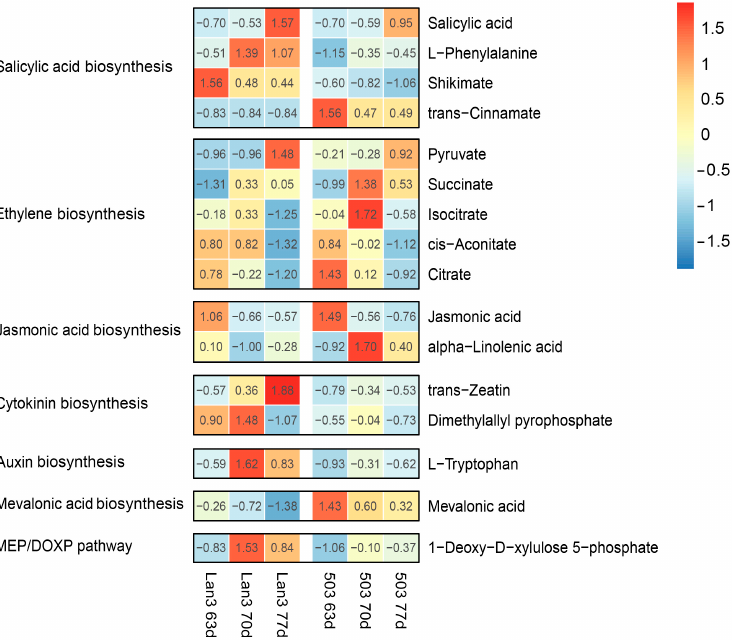
Figure 7. The contents of 16 differential metabolites related to the biosynthesis of plant hormones in Lan3 and 503. The colors indicate the abundance of metabolites calculated as log 2 (Value).